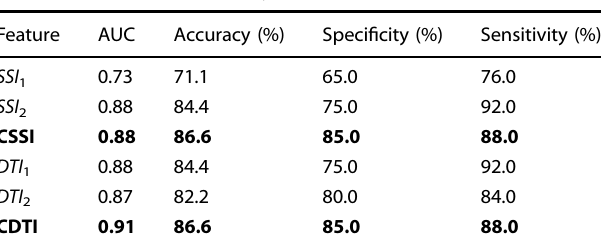
Table 3. Classi fi cation accuracy between PD and MSA.